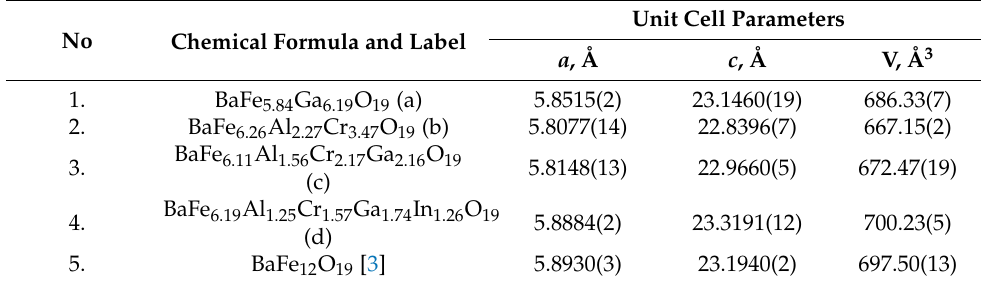
Table 2. Unit cell parameters of the obtained solid solutions.